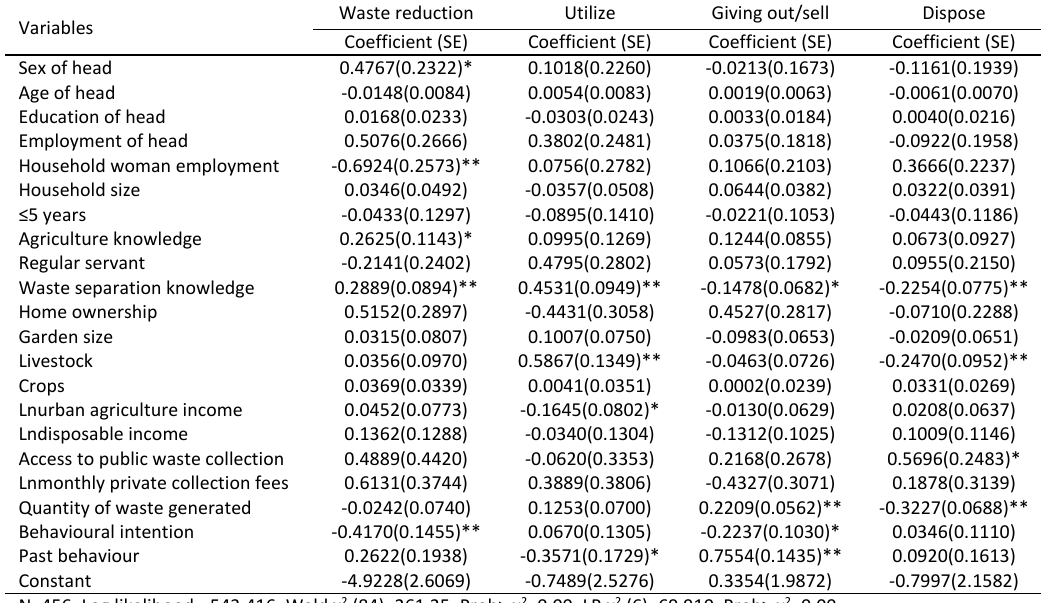
Table 3 : Choice of agro-food waste management options among urban agro-producer